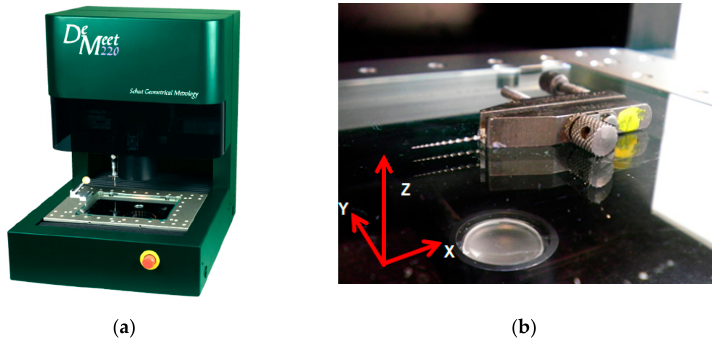
Figure 7. ( a ) OCMM De Meet 220 [29] used for the calibration of the Dog bone, Toggle, and Endodontic file workpieces; ( b ) image of the measuring process of the Dental file workpiece with the OCMM.